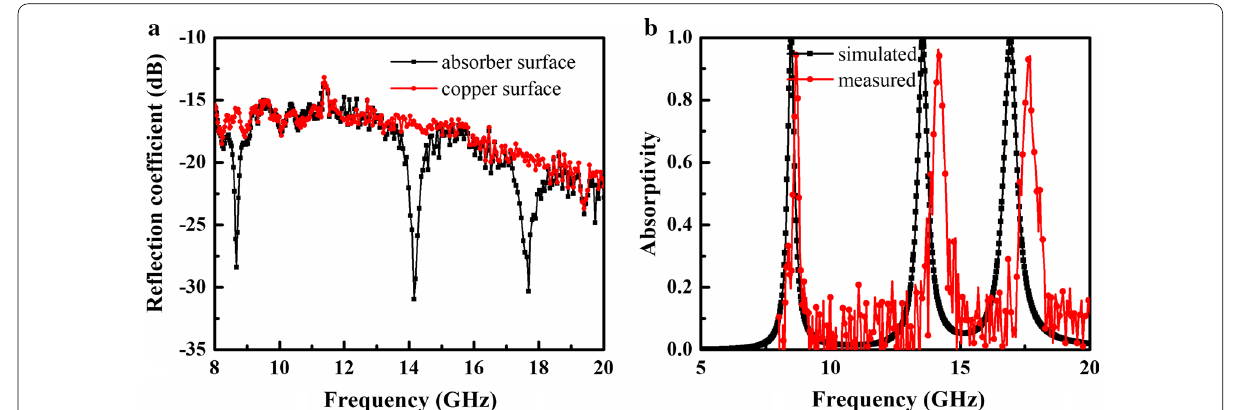
Fig. 8 a Reflection coefficient and b absorptivity of the MA at normal incidence